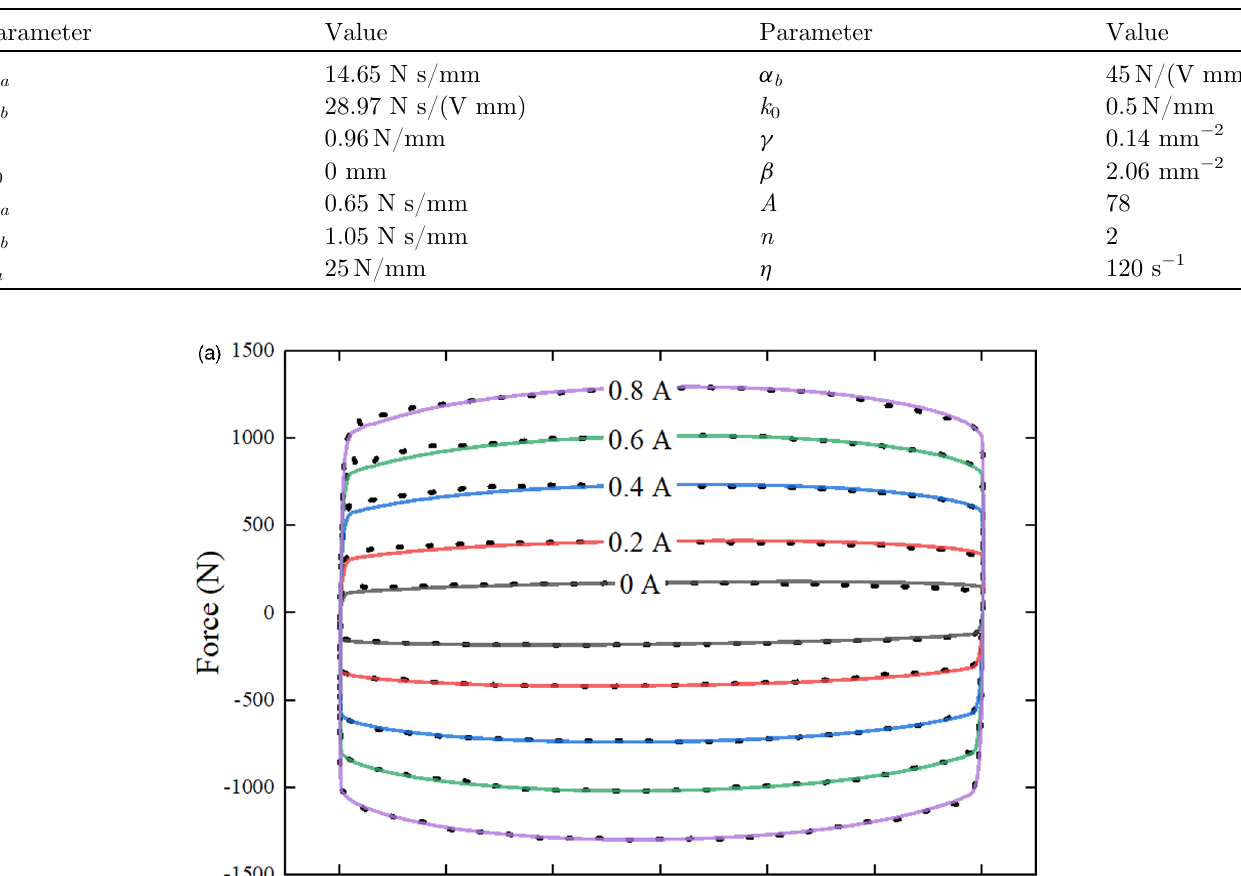
Table 3. Parameter identi fi cation results of the Phenomenon model by IFA.